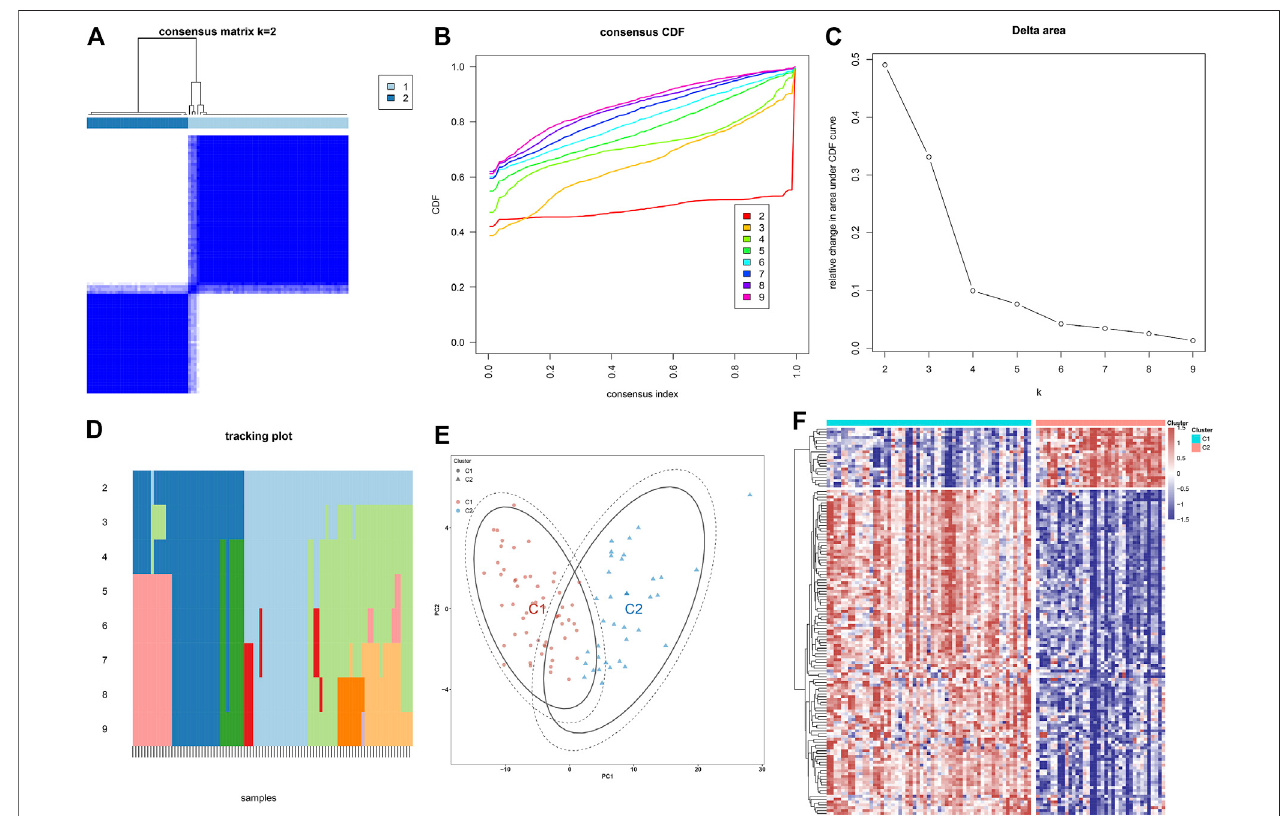
FIGURE 8 | Construction of two immune subtypes of atherosclerosis based on atherosclerotic plaque progression- and immune-associated genes in the combinedGSE28829andGSE43292datasets. (A) Consensusmatrixheatmapwhenk=2. (B) ConsensusCDFwhenk=2 – 9. (C) Relativealterationsintheareaunder CDFcurve. (D) Trackingplotshowingthesampleclassi fi cationwhenk=2 – 9. (E) PCAplotsdemonstratingthatatheroscleroticplaquespecimensarecategorizedastwo immune subtypes (C1, C2) in accordance with the expression pro fi ling of atherosclerotic plaque progression- and immune-associated genes. (F) Heatmap showing the expression of atherosclerotic plaque progression- and immune-associated genes in two immune subtypes.